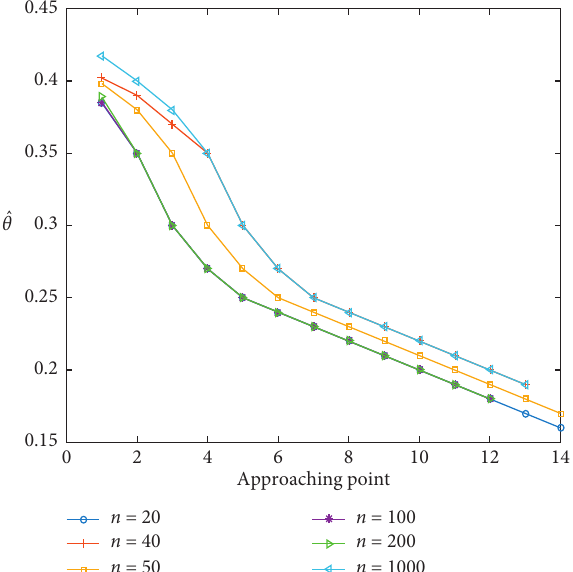
Figure 8: Calibration procedure for different sample sizes.